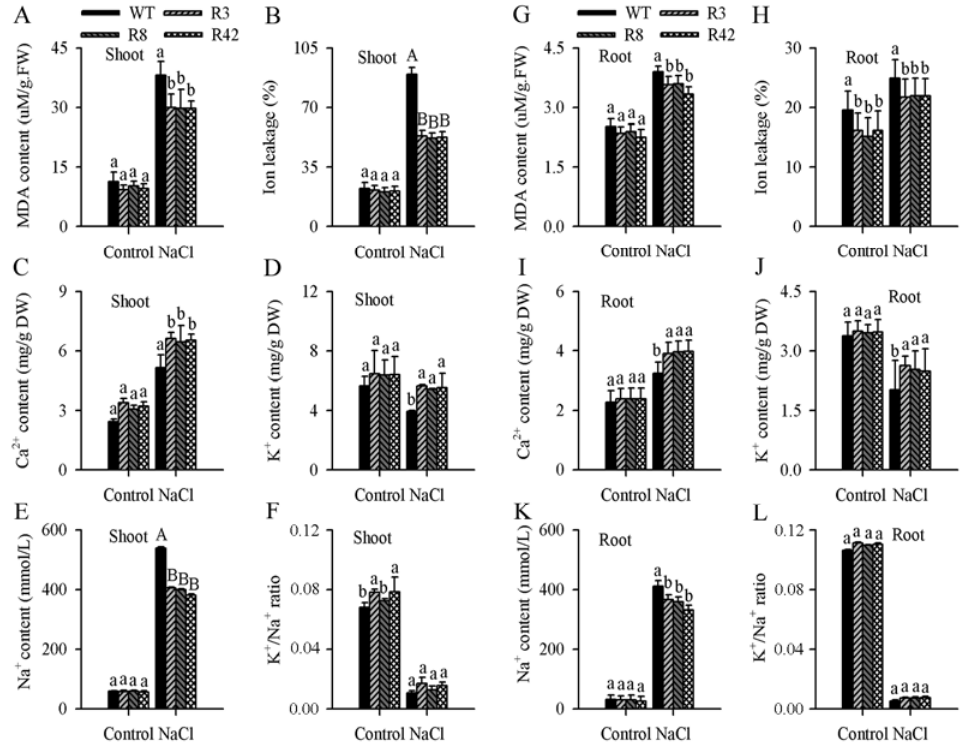
Figure 6. Physiological analyses and ion concentration in roots from wild-type and A. thaliana overexpressing MaROP5g . ( A – F ) Malonaldehyde content, ion leakage, Ca 2+ concentration, K + concentration, Na + ion concentration, and K + /Na + ratio of wild-type and transgenic shoots under normal conditions and salt treatment. ( G – L ) Malonaldehyde content, ion leakage, Ca 2+ concentration, K + concentration, Na + ion concentration, and K + /Na + ratio of wild-type and transgenic roots under normal conditions and salt treatment. WT: Wild-type. R3, R8, R42: MaROP5g transgenic plants. ANOVA was used to compare the significance of differences, using Student’s t tests in the comparison between control and NaCl treatment. Data are presented as means ± standard deviations of n = 3 biological replicates. Different lowercase letters above bars indicate significant differences at p < 0.05, and different uppercase letters above bars indicate extremely significant differences at p < 0.01.